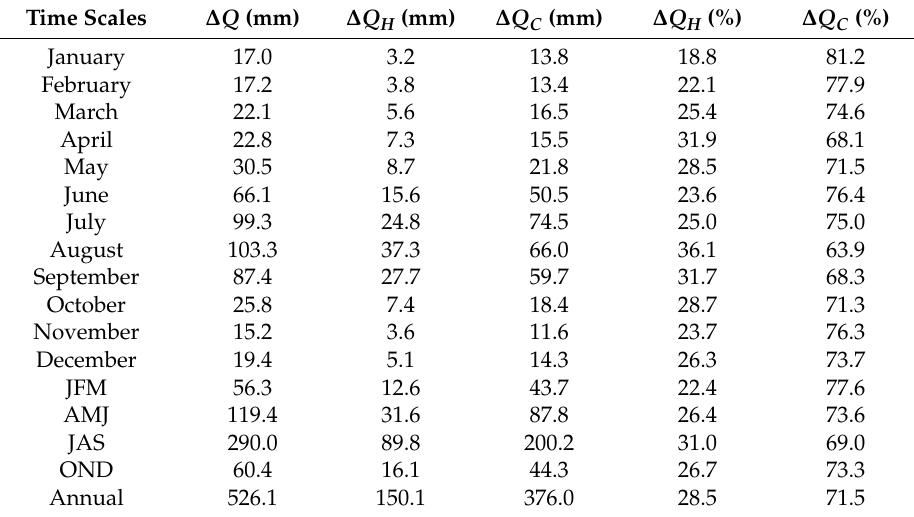
Table 9. Quantitative impacts due to two factors (Soyang Dam upper basin).